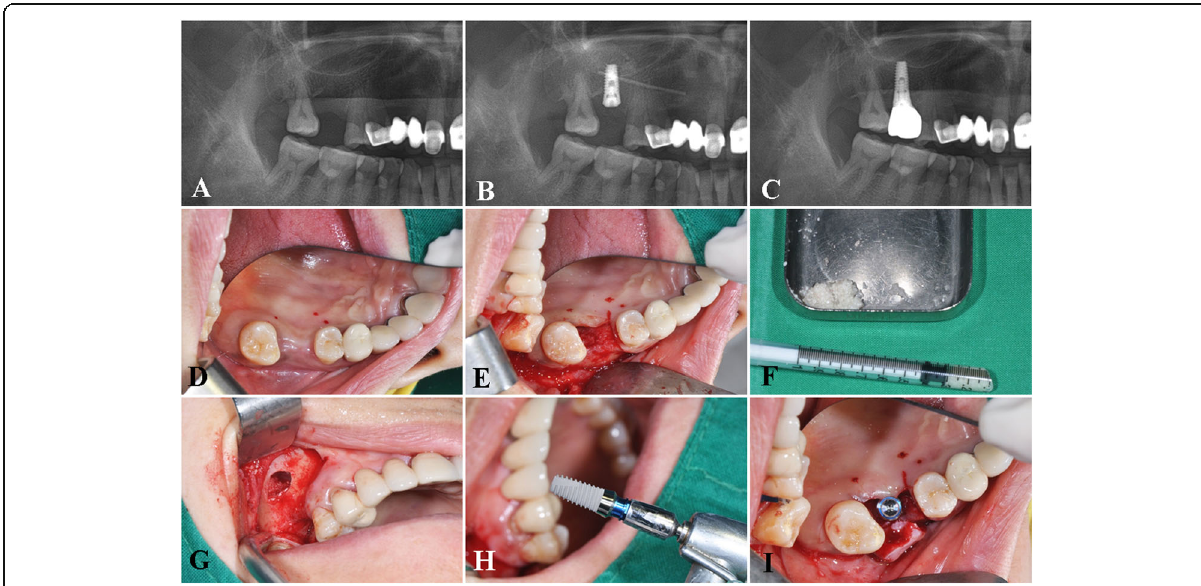
Fig. 4 A case of a Stella® implant placed in combination with a sinus grafting procedure. The pre-operative ( a ), postoperative panoramic view ( b ), panoramic view after prosthesis delivery ( c ), intra-operative view of the sinus graft, and implant placement procedure using an allogenic particulate grafting material, OraGraft® (LifeNet Health Inc., VA, USA) ( d – j